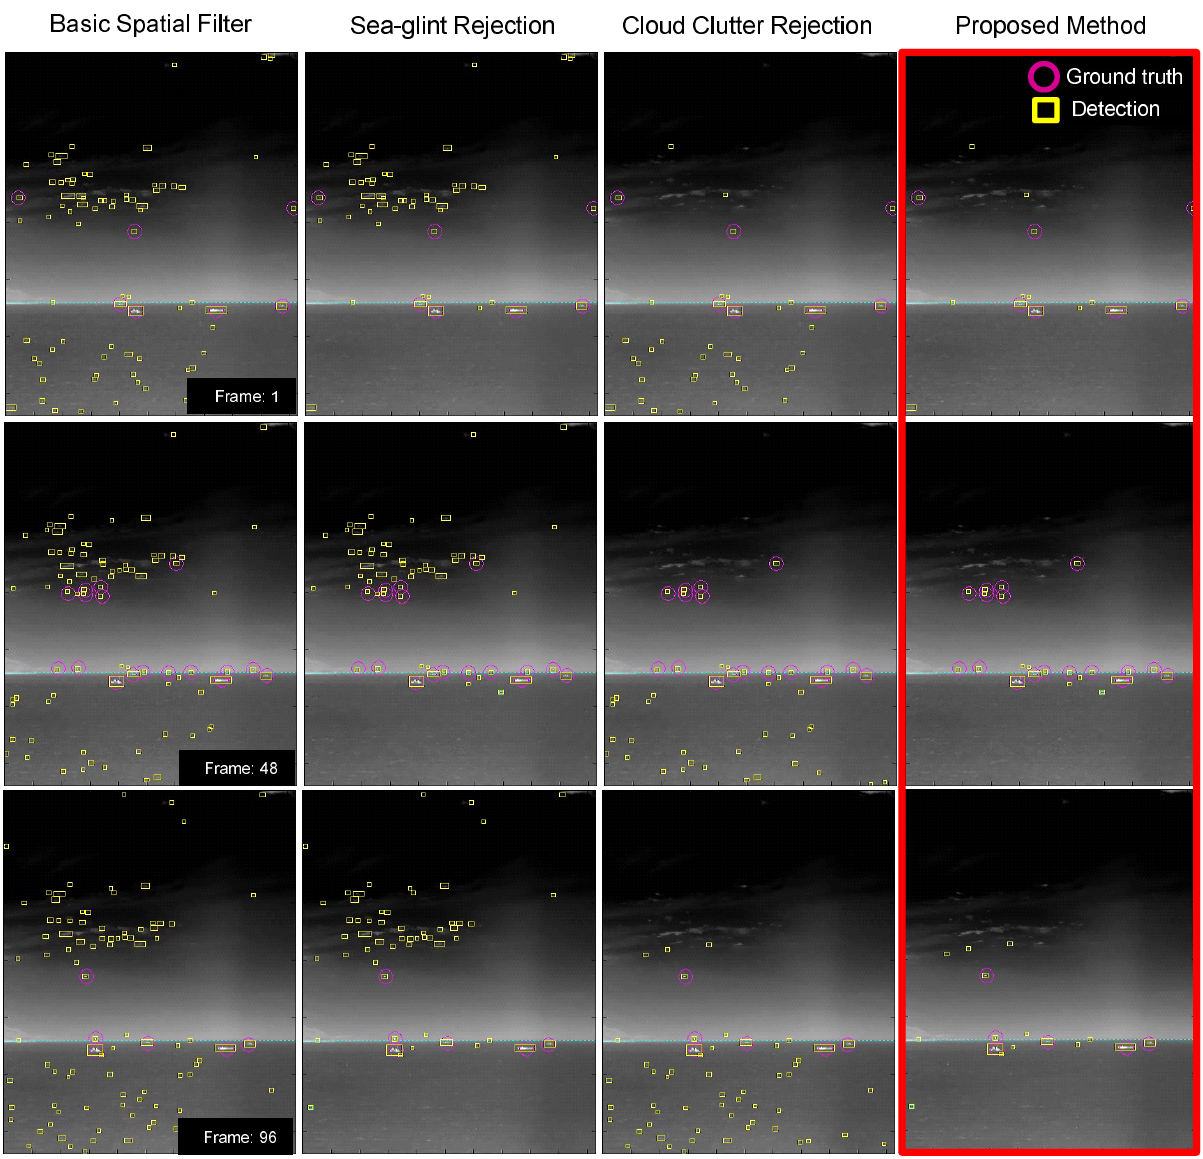
Figure 29. System performance comparison results by applying the clutter rejection methods.